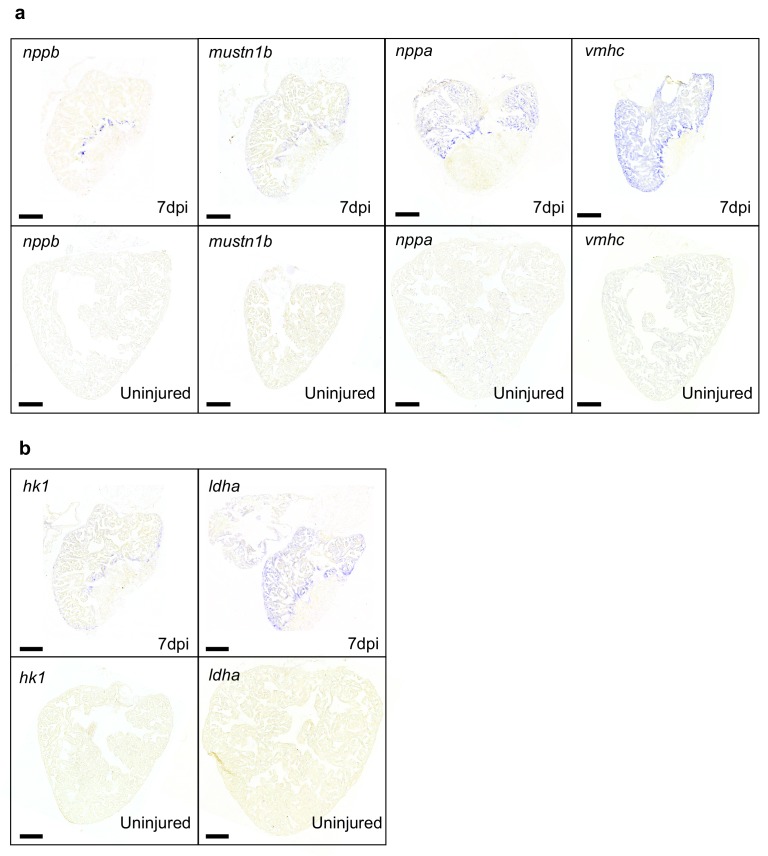
Enhanced expression of genes elevated in cluster 7 versus cluster 2 is injury induced.(a) In situ hybridizations for border zone genes nppb, mustn1, nppa and vmhc in zebrafish hearts at seven dpi compared to uninjured hearts. (b) In situ hybridizations for glycolysis genes hk1 and ldha in zebrafish hearts at seven dpi compared to uninjured hearts. Staining for injured and uninjured hearts was stopped simultaneously. Scale bars indicate 200 μm. (n = 3 per condition).